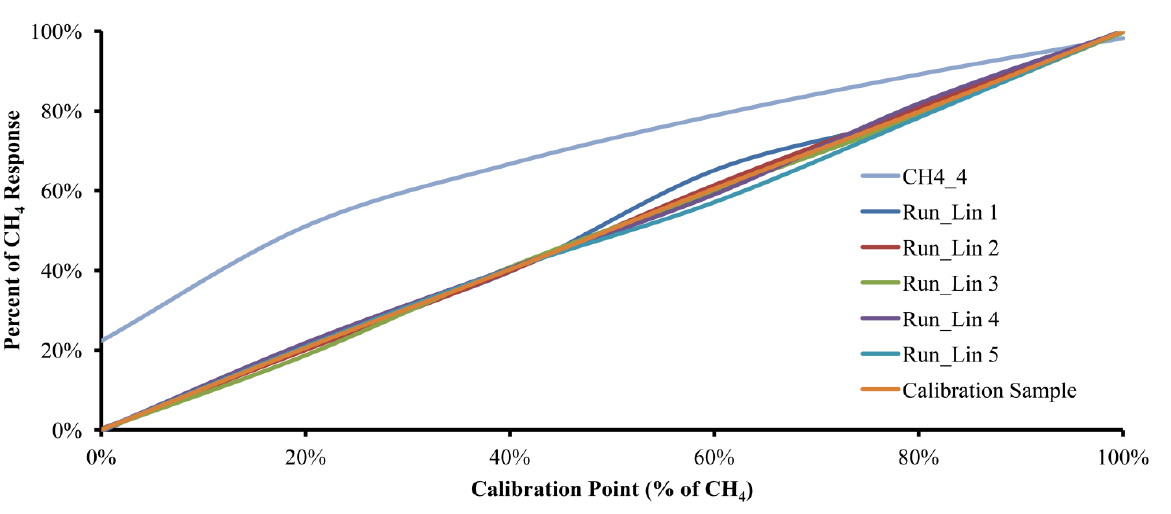
Figure 5. The experimental data after polynomial linearization (run 1 to run 5). In addition, a plot of the mathematical model with 4 moles of absorption liquid and a plot of the Calibration Sample are